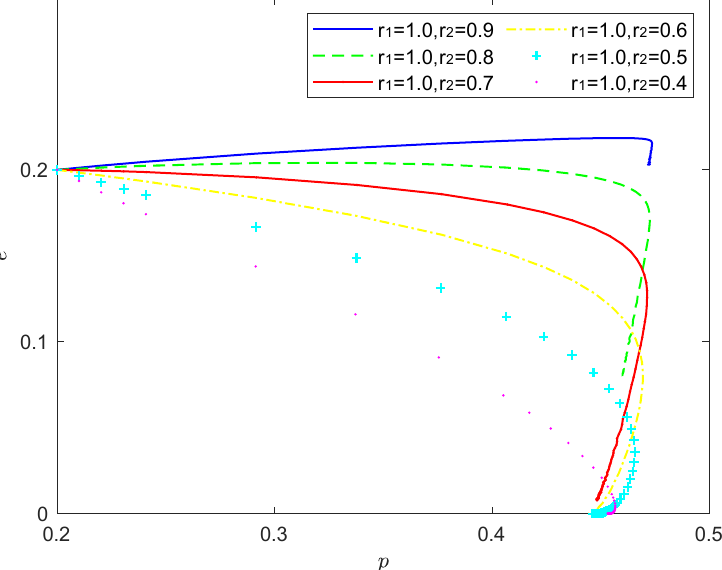
Figure 10. Evolution of game strategy in (rational, optimistic) state.